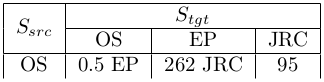
Table from the paper: Monolingual and Cross-lingual Zero-shot Style Transfer
Table text:
S src
S tgt
OS
EP
JRC
OS
0.5EP
262JRC
95